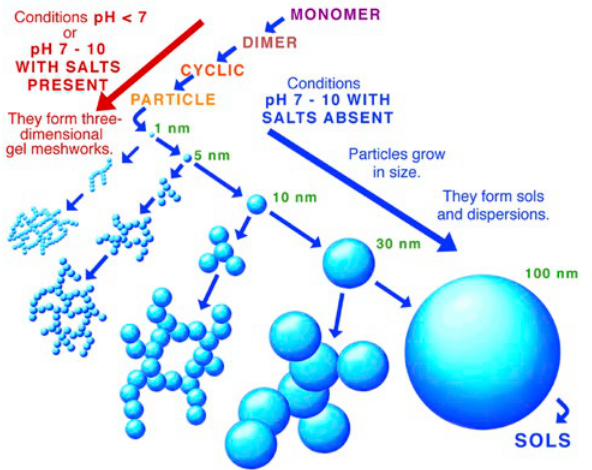
Figure 5. This diagrammatic representation of the polymerisation behaviour of silicic acid indicates the general conditions under which the colloidal particles develop and ‘chain’ into three dimen- sional gel meshworks. In alkaline solution the particles are negati- vely charged and remain discrete as they grow in size and decrease in number. Below pH 7 or in the presence of electrolyte (as in sedi- ment pore fluids) precipitates or gels are formed. [From Iler 2 , 1979, p.